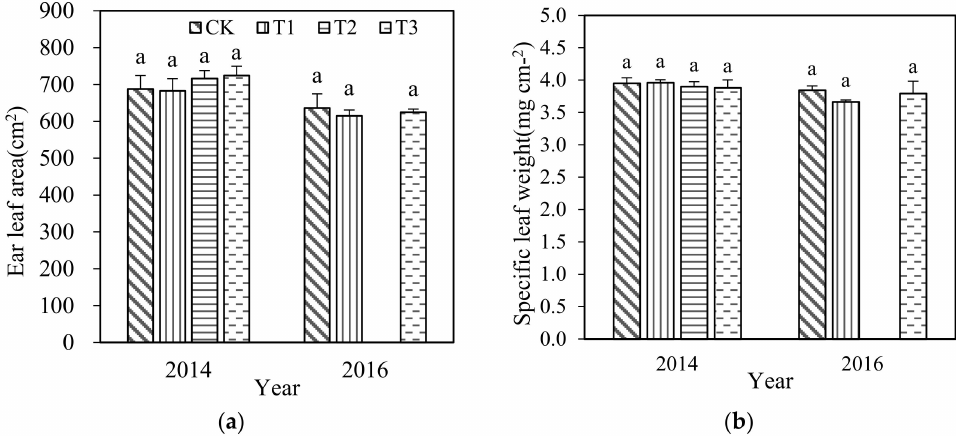
Figure 6. Leaf areas ( a ) and specific leaf weight ( b ) for the ear leaf at blister stage in 2014 and 2016. CK, T1, T2, and T3 denote the control, nocturnal warming during the whole growth season, and nocturnal warming during the vegetative and reproductive stages, respectively. The same letters on the pillar indicate no significant difference among the treatments in the same year ( p <